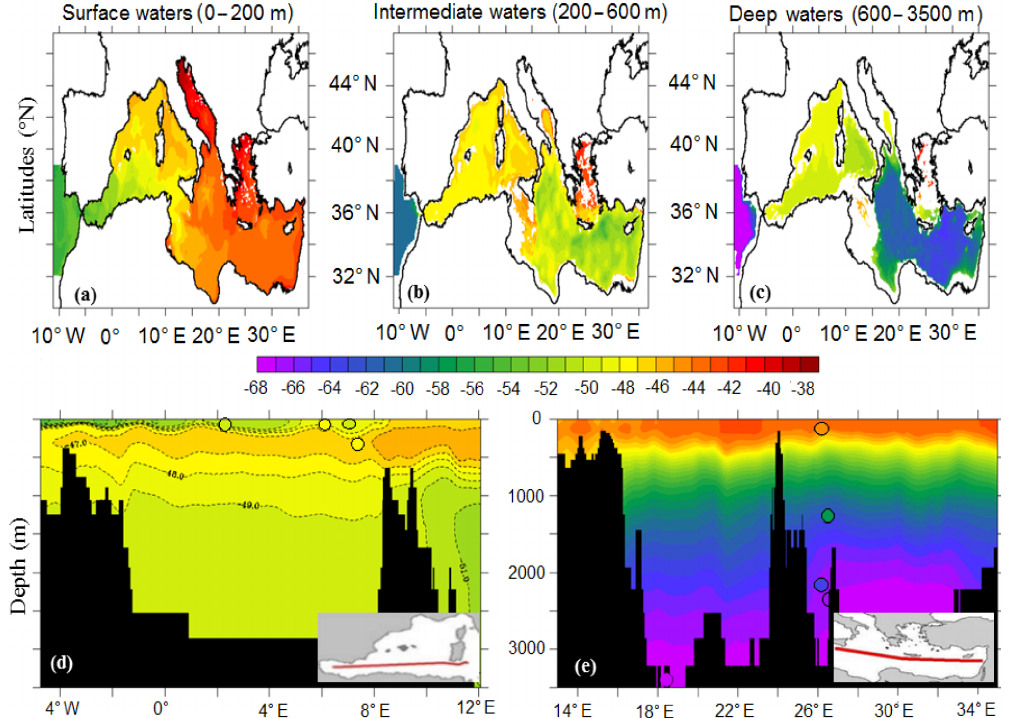
Figure 2. Model output for March 1956 showing the pre-bomb situation. Upper panel: mean (cid:49) 14 C (in‰) in surface waters (0 to 200m), intermediate waters (200 to 600m), and deep waters (600 to 3500m). Lower panel: (cid:49) 14 C along E–W section in (d) WMed and (e) EMed, where colour-filled dots represent in situ observations (Broecker and Gerard, 1969). Both model and data are reported with the same colour scale.